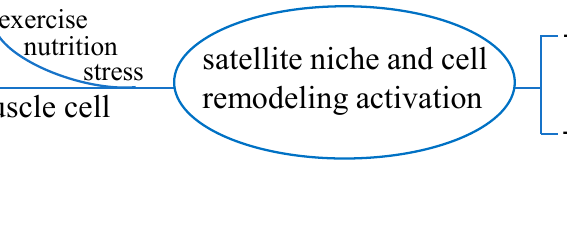
Figure 2. Hypertrophic and non-hypertrophic functions of skeletal muscle cell remodeling. In addition to hypertrophic function to satisfy the need of fiber size modification and repair, non-hypertrophic function seems to constantly refresh transcriptome/proteome renewal to warrant correct adaptative processes in response to stimuli such as exercise, nutrition or stress.